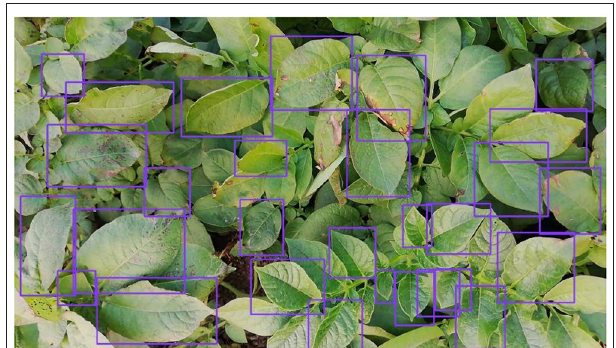
FIGURE A2 | Prediction of the best model trained on the PFD dataset and live labeling of the sample images.